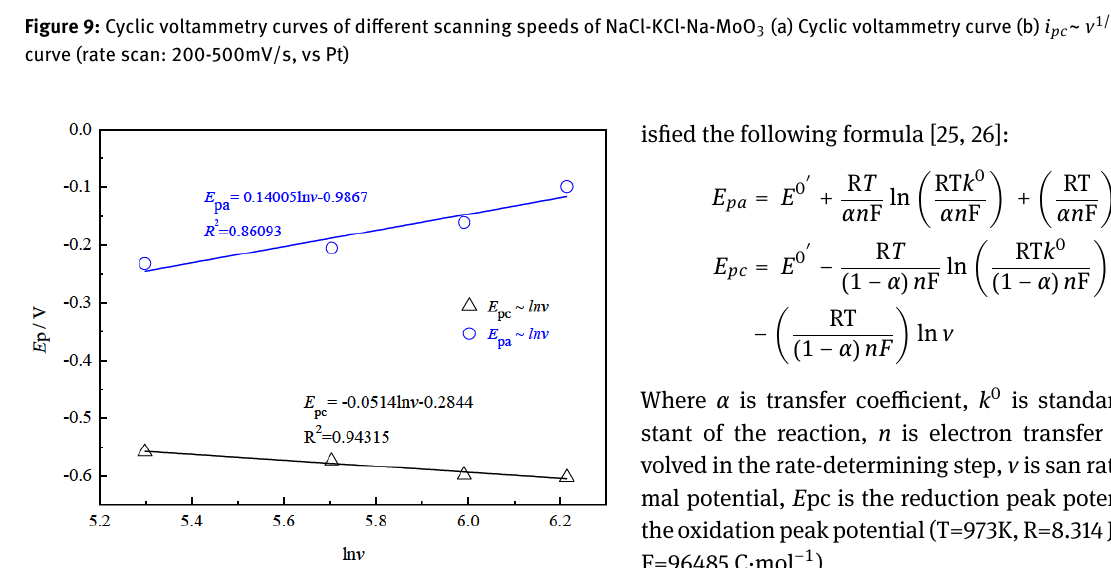
Figure 10: ln v vs. E